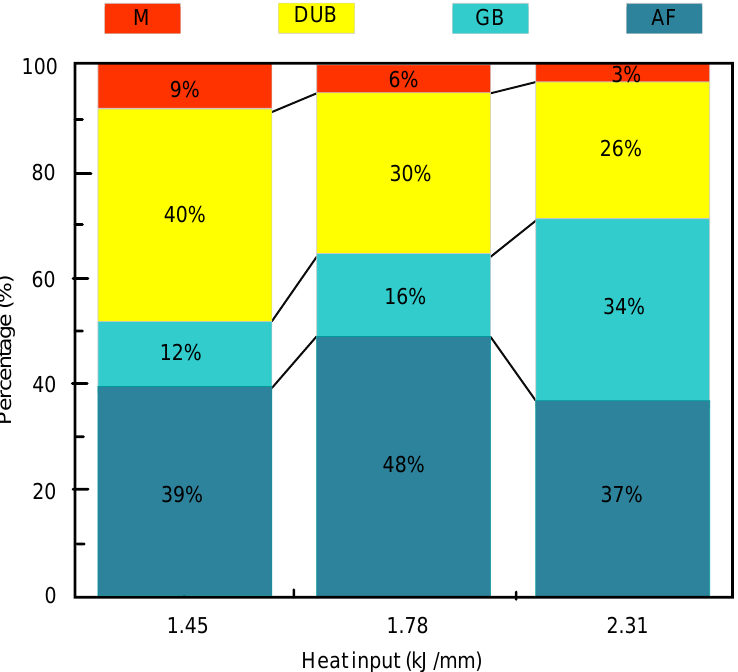
Figure 8. Quantitative statistical diagram of microstructure of deposited metal.